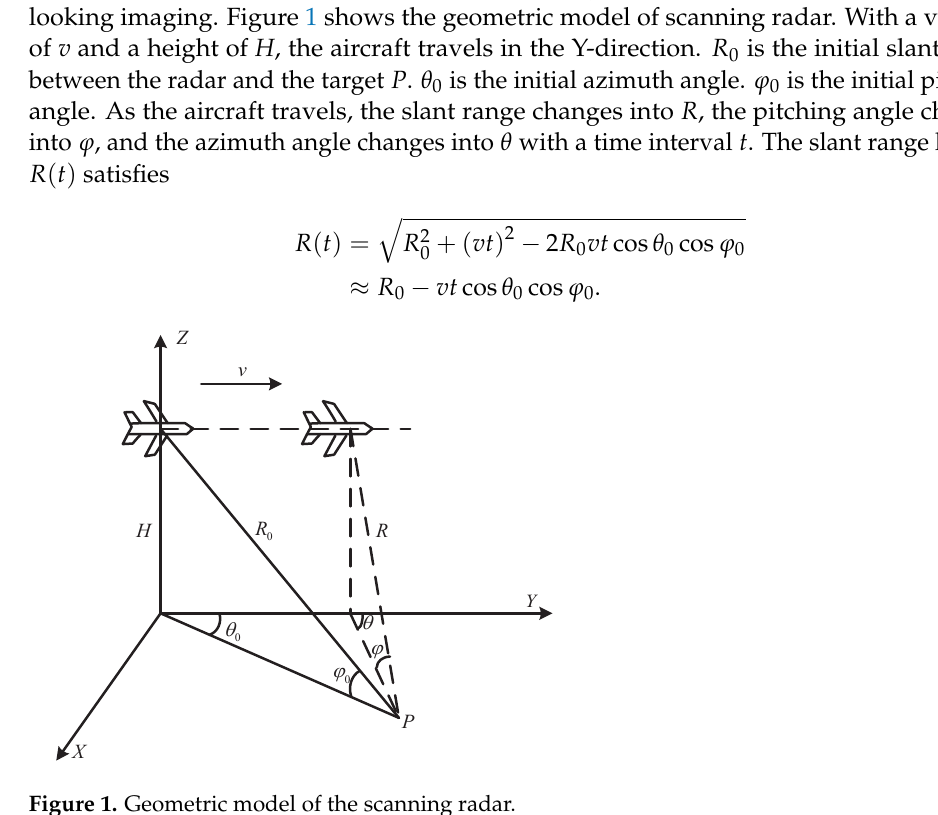
Figure 1. Geometric model of the scanning